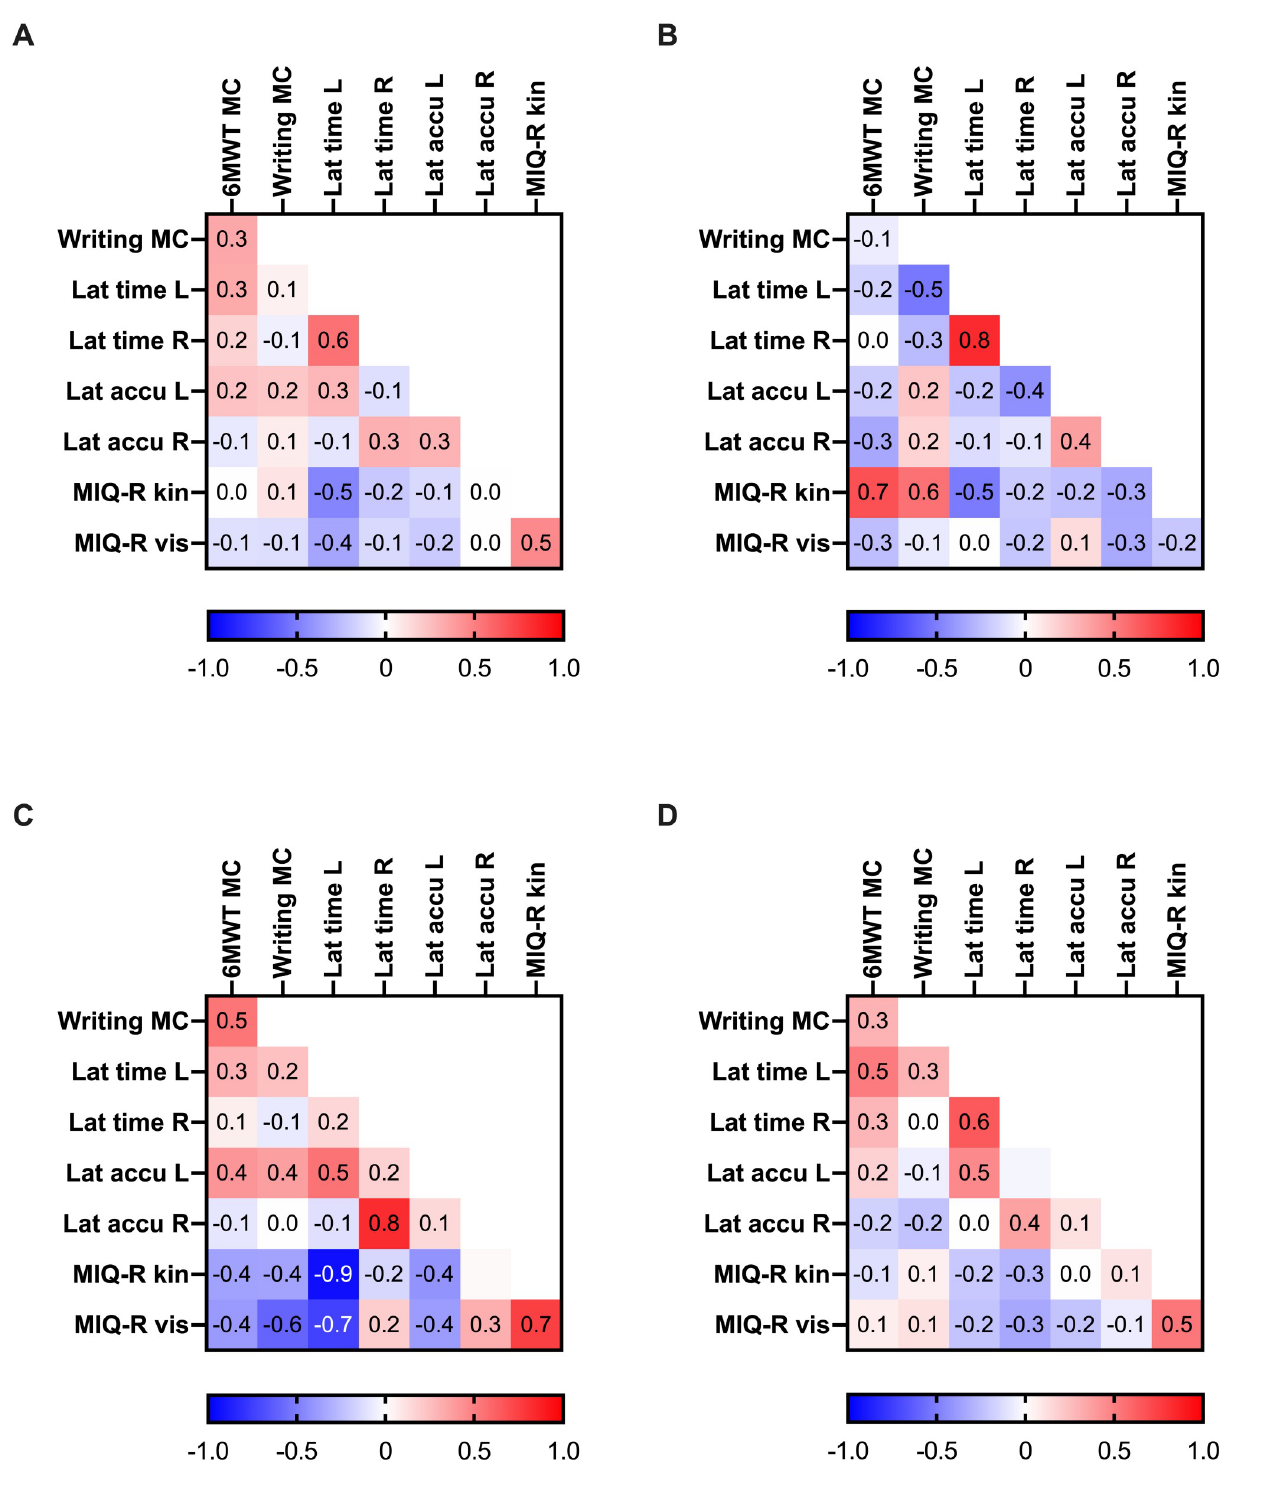
Fig 2. Correlations between the motor imagery ability assessments at baseline. The heatmap presents Spearman’s Rank correlation coefficients (ranging from-1 to +1) of MI ability measures, where darker blue and red fields signify stronger correlations. ( A ) All participants. ( B ) Activating MI group. ( C ) Relaxing MI group. ( D ) Control